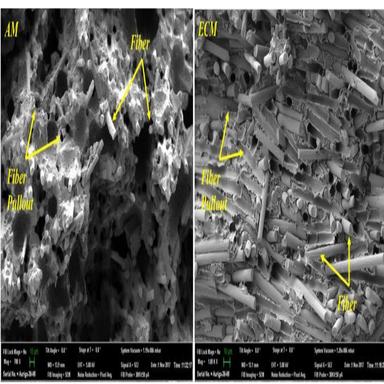
SEM micrographs of a fracture surface of tensile samples; (a) EDF-AM: Most of the fibers are aligned in printing direction, also contain voids; (b) ECM: Fibers are well distributed in all directions and (c) IM: Fibers are well aligned in flow directions. All samples showed fiber pullout.